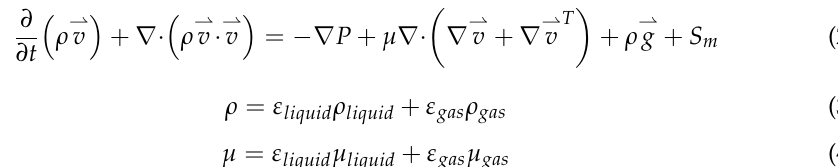
( c ) Figure 3. Steady state flow distribution at velocity = 0.25 m ⋅ s − 1 : (a) parallel; (b) serpentine; and (c) symmetry. At a lower water velocity of 0.25 m ⋅ s − 1 (Figure 3), all flow field designs experienced difficulty in forming substantial liquid film across all channels, thus leading to poor flow distribution. This result is in line with other studies, where a higher inlet velocity is pref- erable to increase the efficiency of the mass transfer of liquid reactant and also to achieve a better gas removal rate [9,17]. At an increased velocity of 0.75 m ⋅ s − 1 , no noticeable im- provement was observed at a steady state for both symmetry and serpentine configura- tions. As shown in Figure 4f, symmetry flow field showing similar flow pattern as Figure 2c. Furthermore, the parallel flow field achieved a steady state at 0.15 s, as shown in Figure 5c. Then moving towards the serpentine flow field shown in Figure 6f, again similar flow pattern was observed. A higher water velocity resulted in the build-up of liquid film across the flow field at a higher rate leading to a steady state, but the flow distribution was significantly affected by the flow field geometric structure. As the temperature of the fluid is excluded from this simulation study, it is to be noted that the effect of water ve- locity on the interaction of the two-phase flow has been reported to have a correlation with operating temperature [18]. Therefore, there is a further improvement on the current flow field design with optimisation in both the flow rate of liquid water and temperature simultaneously.